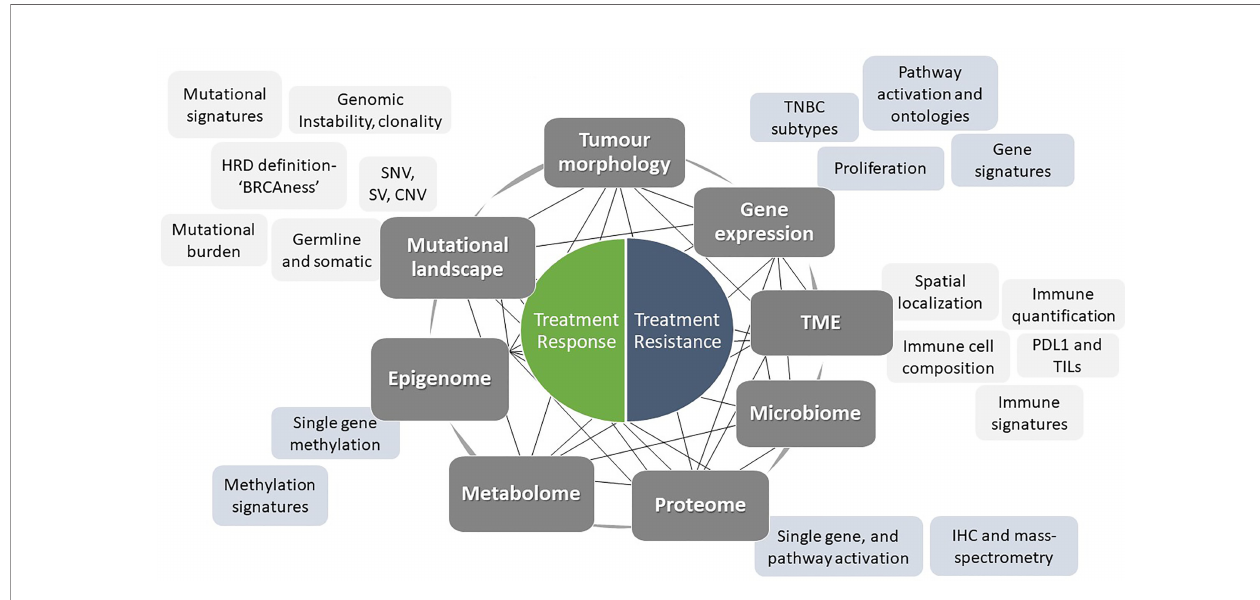
FIGURE 2 | Biomarker landscape in